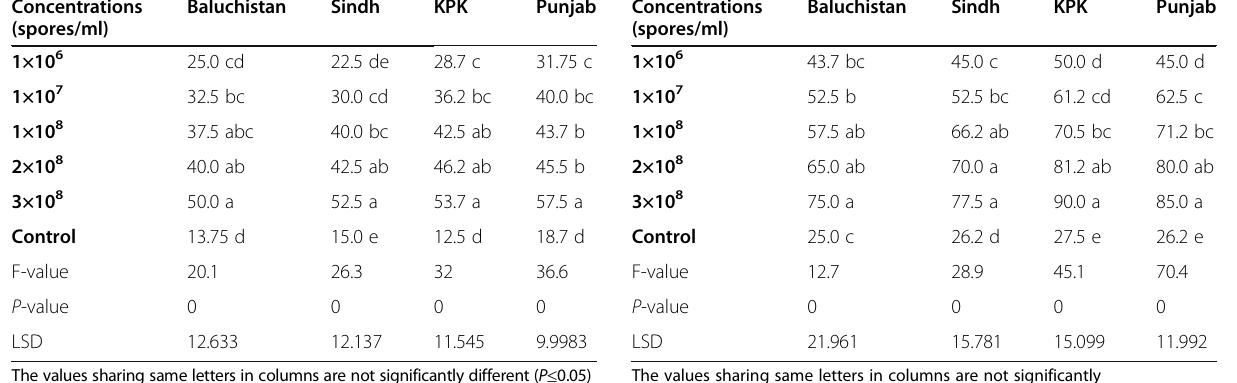
Table 2 Percent mortalities of Rhynchophorus ferrugineus on the 3rd day after treatment with Beauveria bassiana Concentrations (spores/ml)